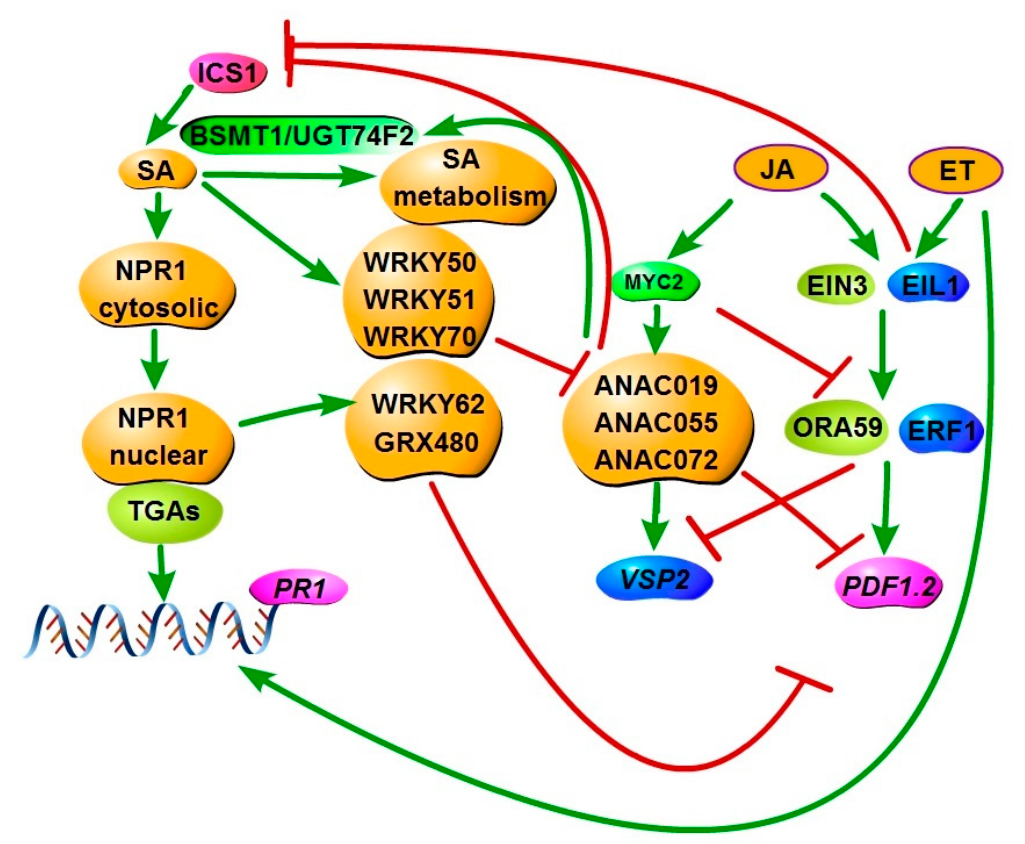
Figure 3. Interactions between the SA and the JA/ET pathways. ET can synergistically induce PR1 via an unknown mechanism. SA and JA/ET are mostly antagonistic to each other. On the left-hand (SA) side, the cytosolic localization of NPR1 is sufficient for the suppression of the JA/ET response. Some components that are regulated by NPR1, such as WRKY62, TGAs, and glutaredoxin 480 (GRX480), can confer the suppression on the JA response. Some WRKYs such as WRKY50, WRKY51, and WRKY70, can suppress the JA response independent from NPR1. The suppression of the JA pathway by the SA pathway is downstream of JA synthesis, having no influence on JAZs accumulation; however, it results in the degradation of ORA59. On the right-hand (JA) side, JA can suppress the SA response by inducing ANAC s, which are regulated by MYC2 . ANACs can inhibit isochorismate synthase 1 (ICS1); however, they can enhance the basal transcript level of the SA methyl transferase 1 (BSMT1) and UDP-glucosyltransferase 74F2 (UGT74F2) to elevate SA accumulation. Furthermore, EIN3 and EIL1 can suppress ICS1 activity by directly binding to the promoter of ICS1 . Activation (closed arrowhead), suppression ( ⊥ ), and important genes are indicated.